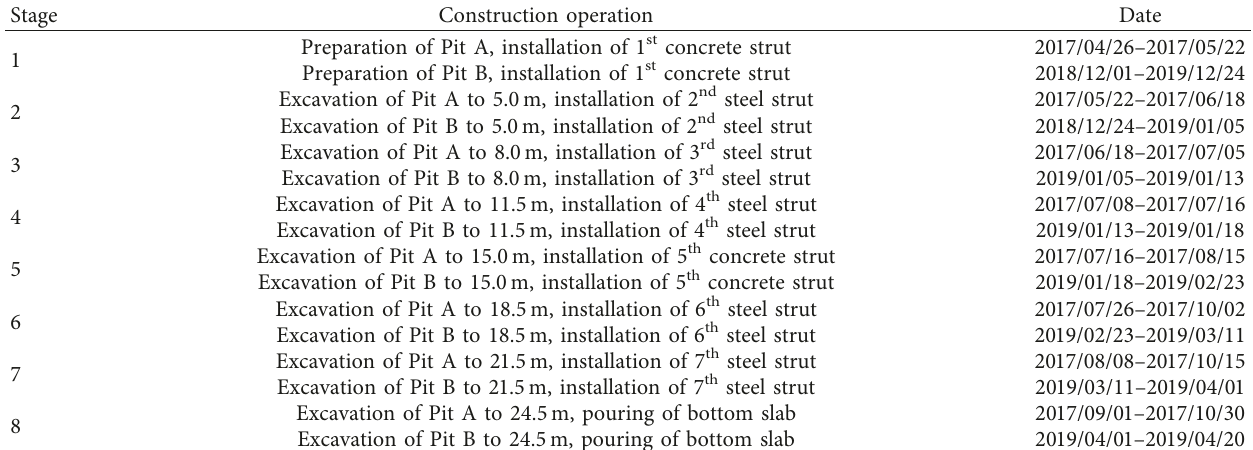
Table 1: Construction operation of the foundation pit.